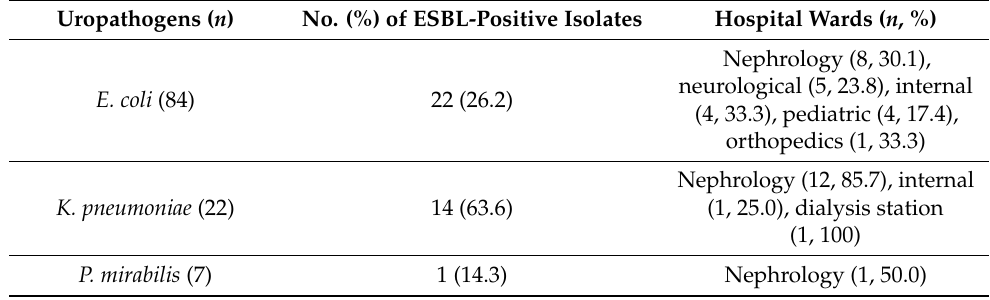
Table 8. Occurrence of ESBL-positive uropathogens in patients hospitalized in different hospital wards.